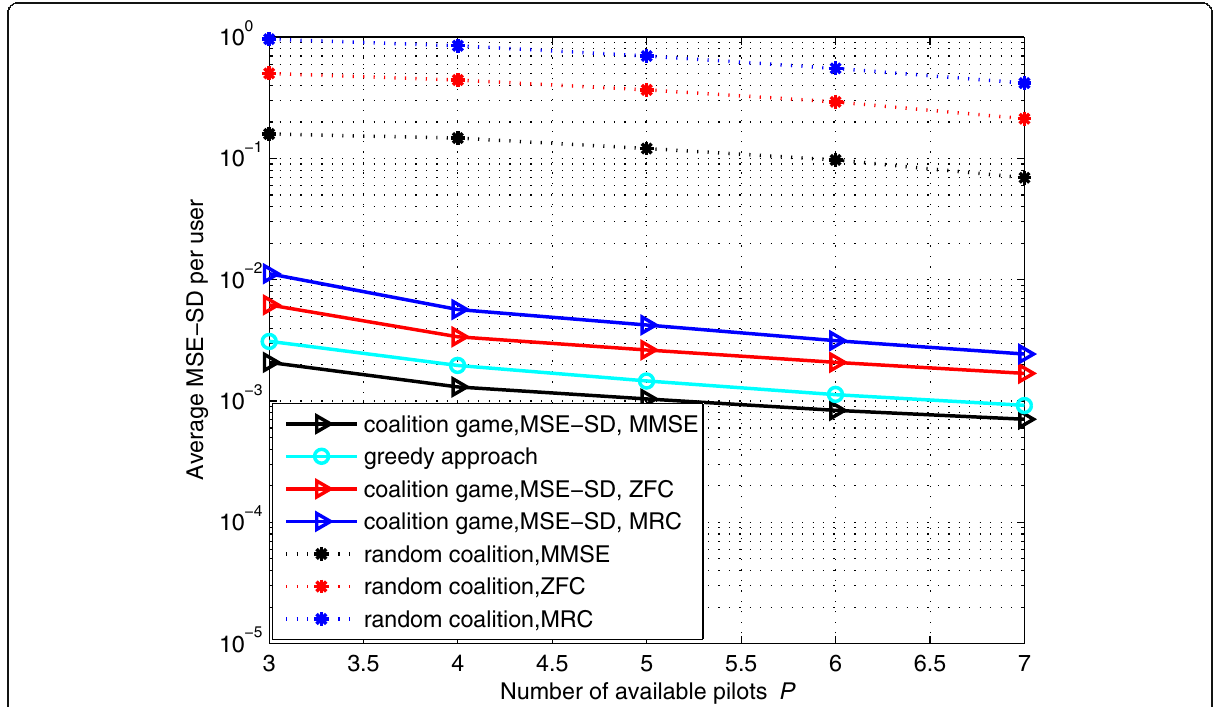
Fig. 10 Average MSE-SD versus the number of pilots with T = 20 dBW